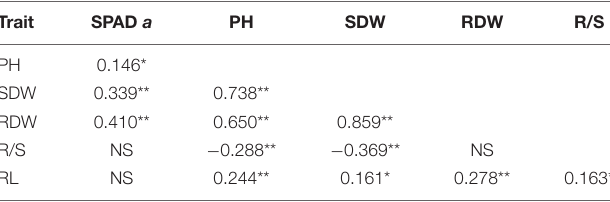
TABLE 2 | Pearson correlation coefficients between each trait under Fe deficiency.